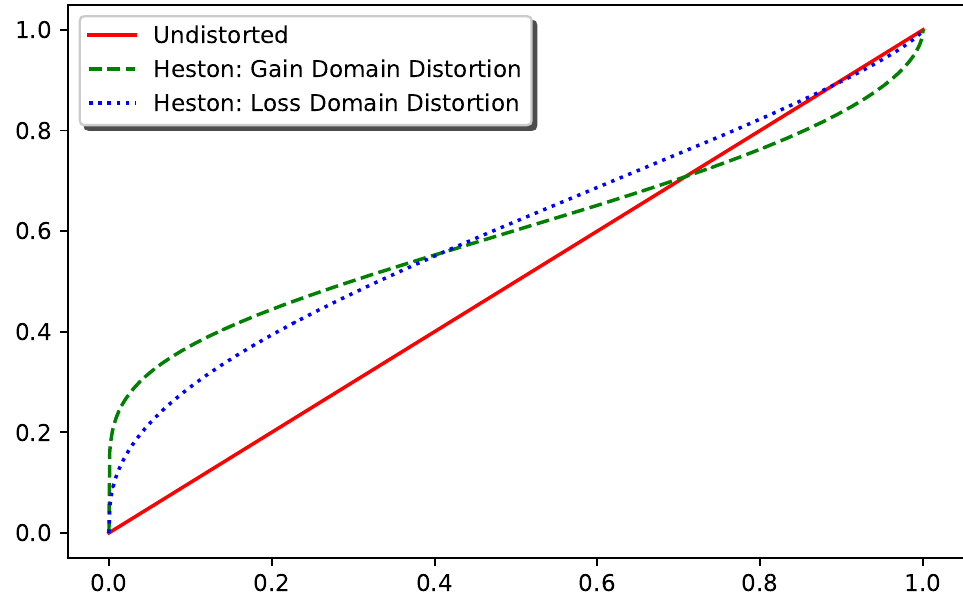
Figure 3. Distortion functions for the Heston model with mean probability distortion values γ = 0.555 and δ = 0.623 for the gain domain and γ = 0.791 and δ = 0.640 the loss